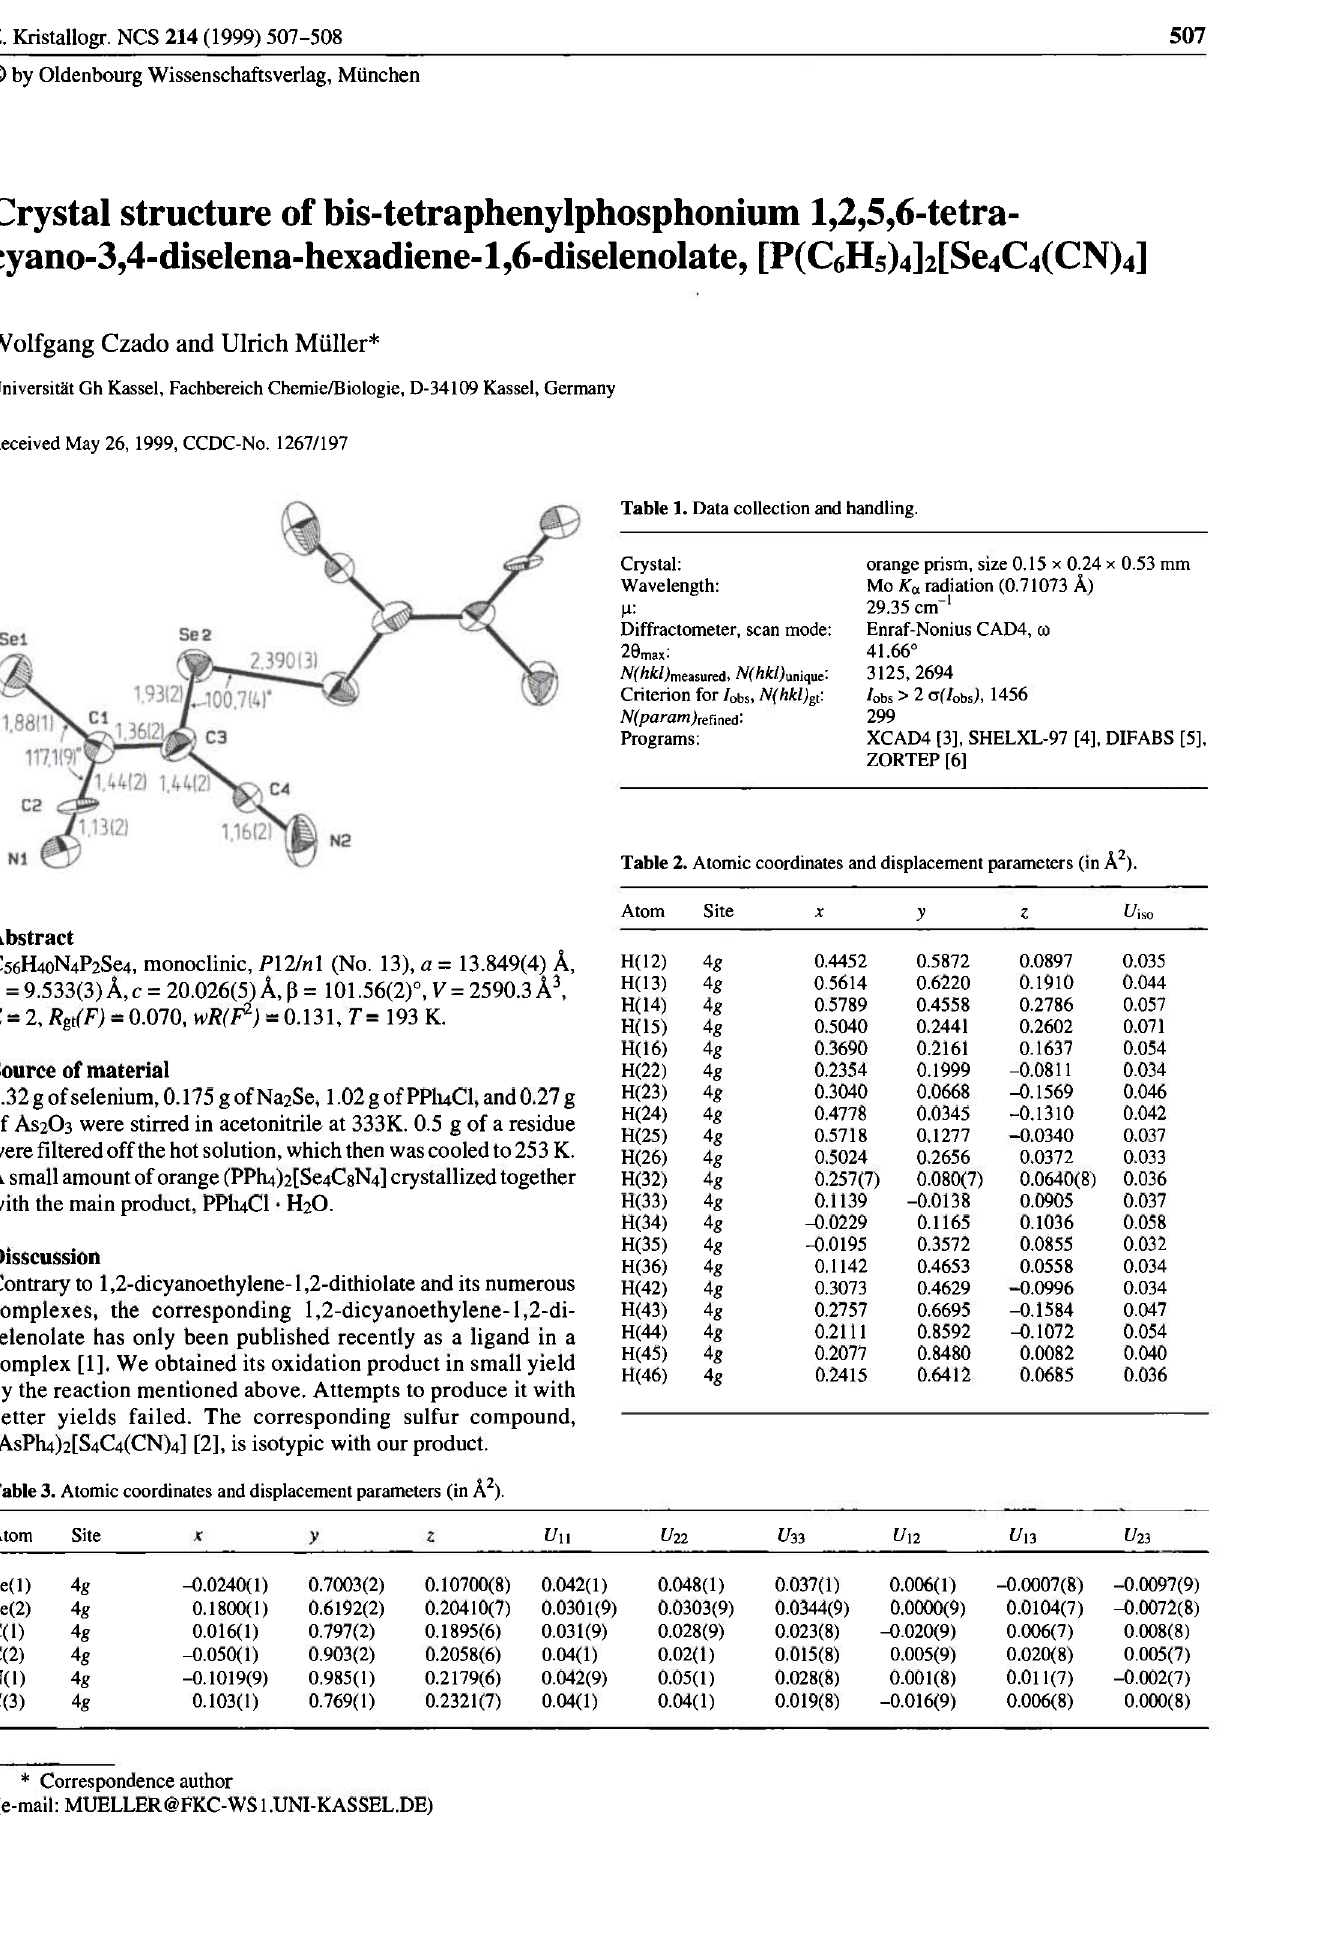
Table 3. Atomic coordinates and displacement parameters (in Ä 2 ).